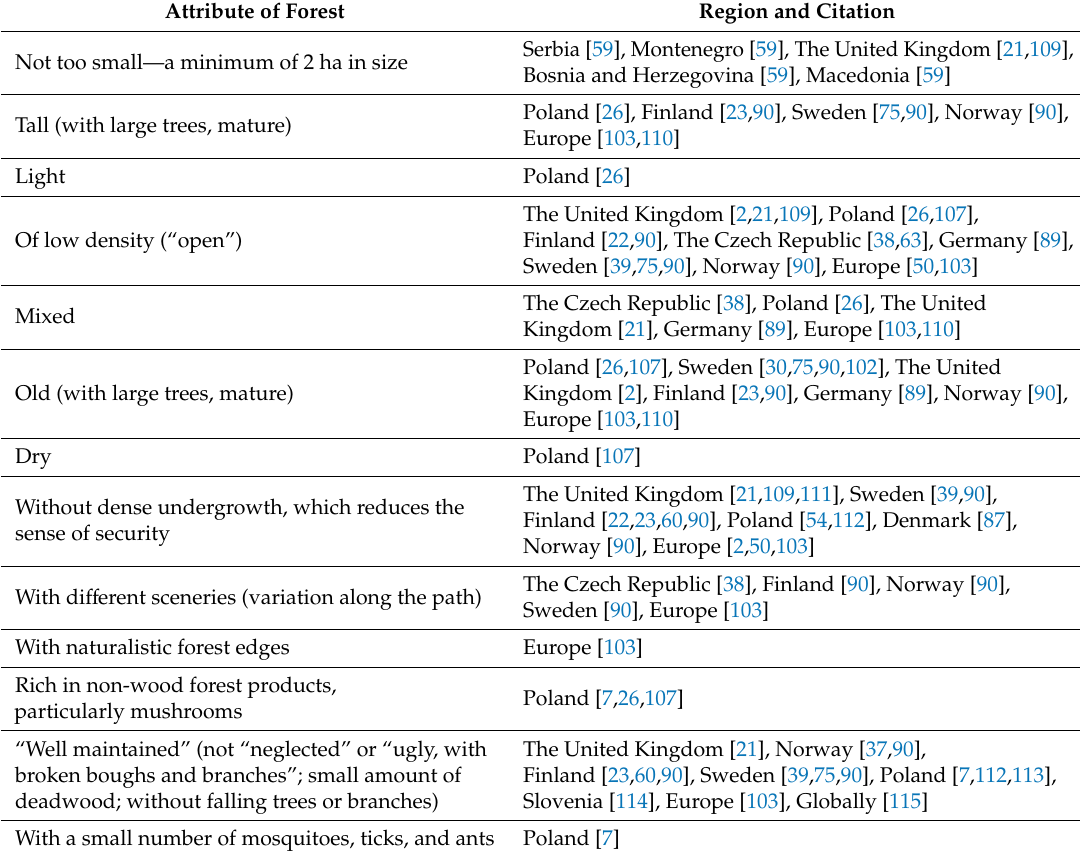
Table 3. Social preferences concerning the appearance and quality of urban and suburban forests. Attribute of Forest Region and